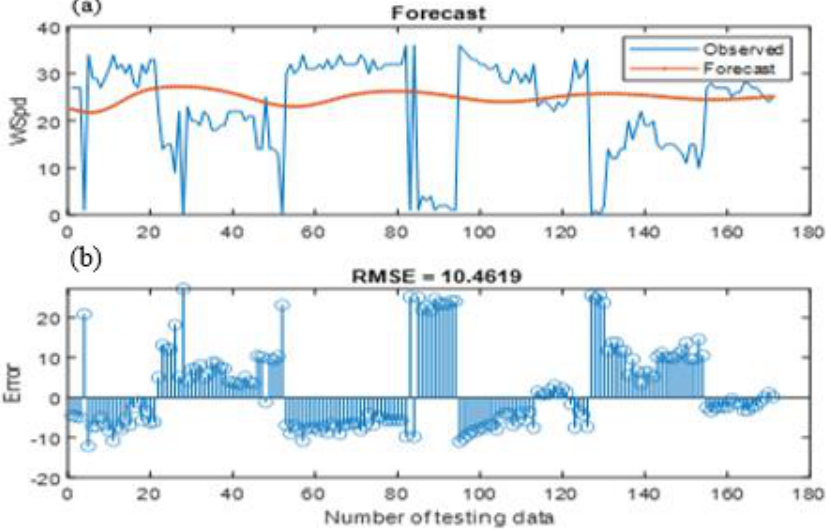
Figure 4. Wind speed prediction of existing LSTM for Spring (March 2015) data: ( a ) Comparison of observed values and forecast values; ( b ) Error and RMSE value values.